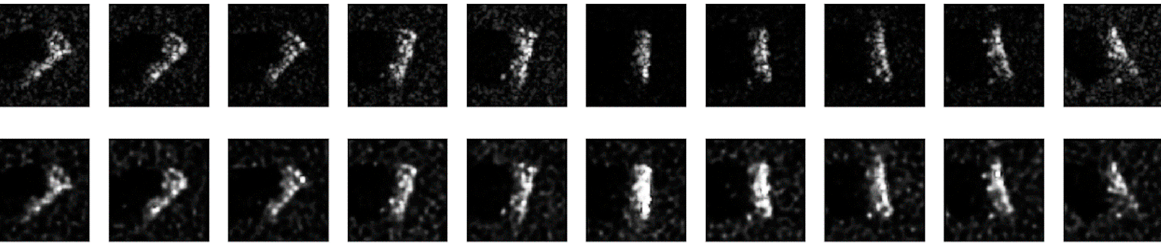
Figure 5. Model parameters setting.